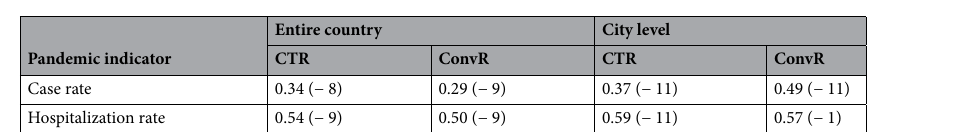
2 Table.2. Highest coefficient of determination ( R ) and its lag in days (in parenthesis), for different parameters of the advertising system and indications of the pandemic. Negative lag indicates that data from the advertising system leads that of the pandemic.